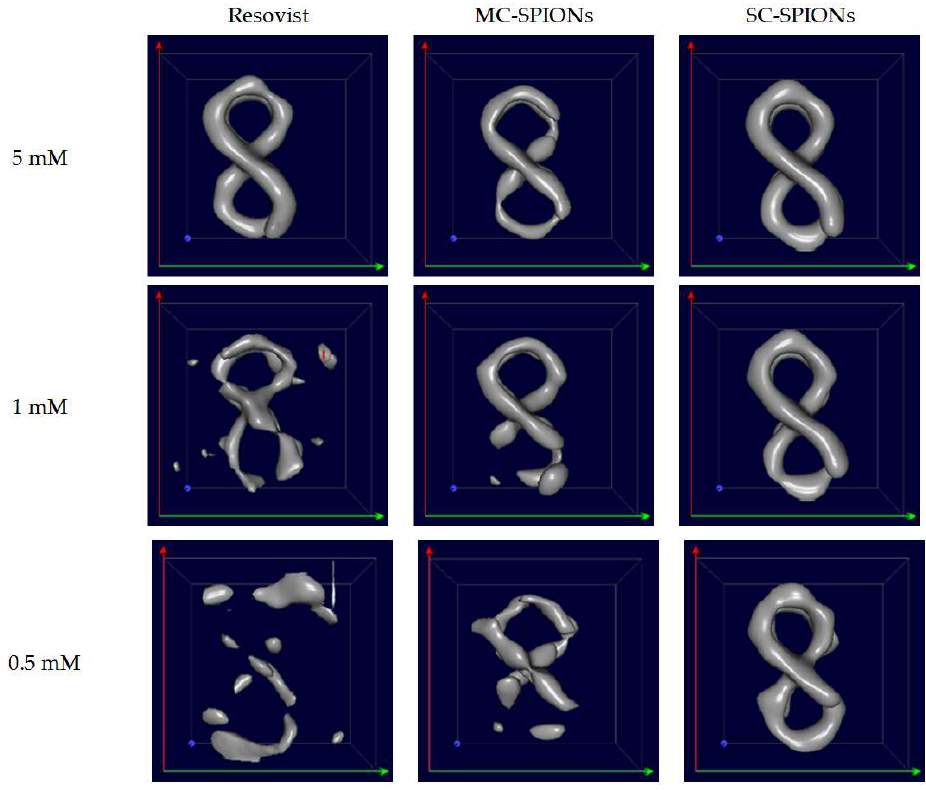
Figure 7. Reconstructed MPI images of phantoms using 5 mM, 1 mM, and 0.5 mM of Resovist, SC-SPIONs, and MC-SPIONs.